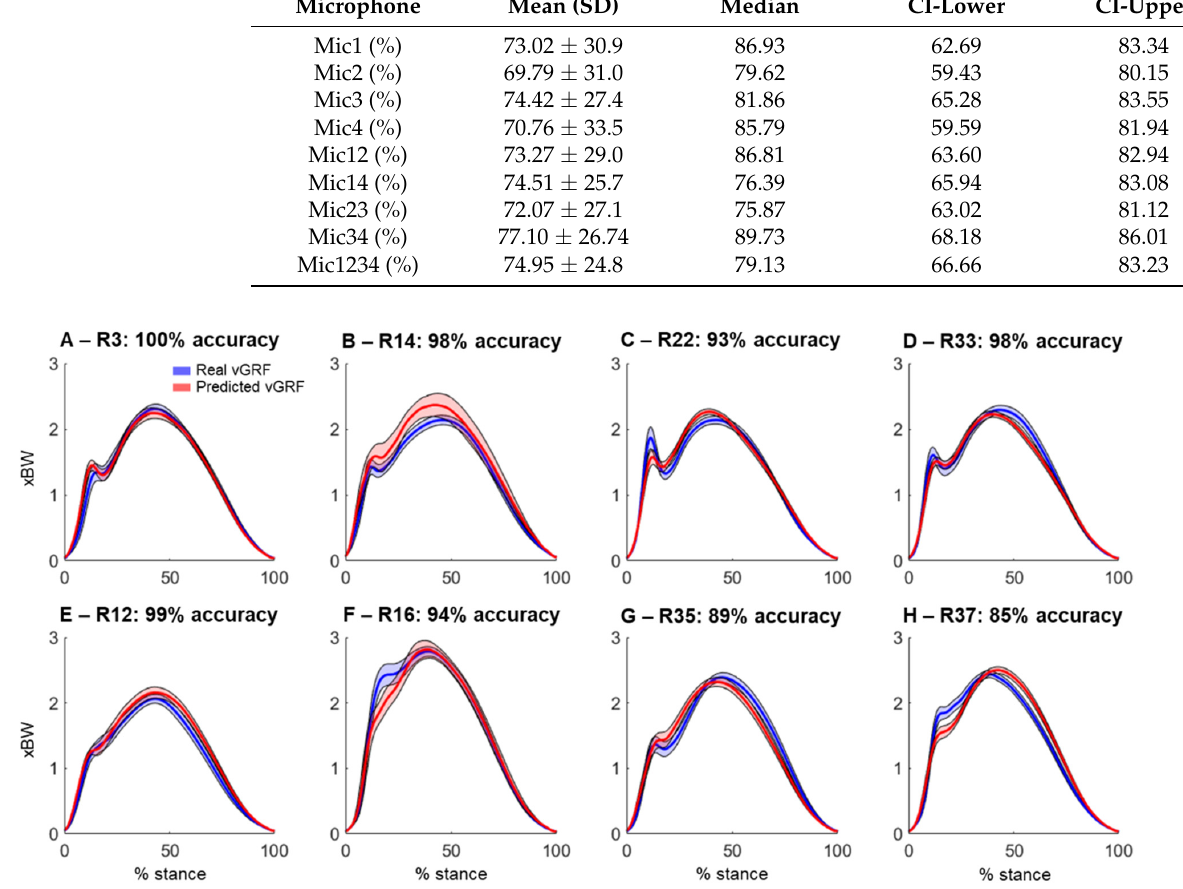
Figure 5. Real (blue) and predicted (red) vertical ground reaction forces (vGRF) from selected runners (R) presenting prominent impact peaks ( A – D ) and with absent impact peaks ( E – H ). Thick lines represent data average and shaded areas represent standard deviation. For each runner, the overall accuracy in determining presence/absence of impact peaks is shown in the figure subplot titles.